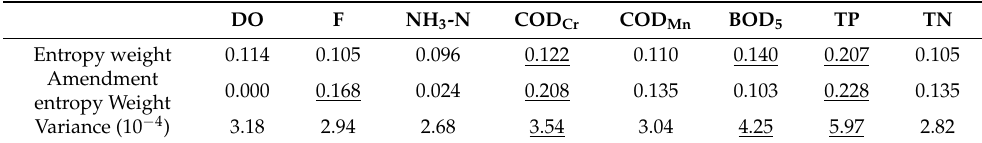
Table 3. Weight values and variance of